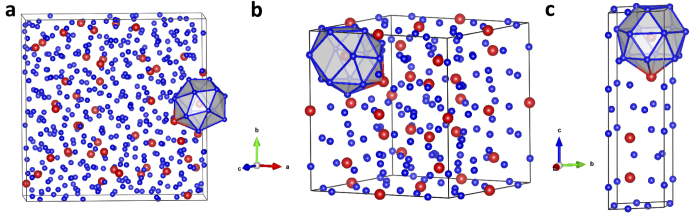
The commonly shared T6 motif in AlSm liquid and crystal structures.(a) The T6 packing motif around Sm atoms in simulated Al450Sm50 undercooled liquid sample at 800 K; (b) The T6 motif in Al120Sm22, the Al-Sm big cube phase, which is the first observed crystal structure from the devitrification process of Al90Sm10 samples prepared by melt spinning; (c) The T6 motif in Al20Sm4, which is one of the first devitrified phases from Al90Sm10 samples prepared by magnetron sputtering.